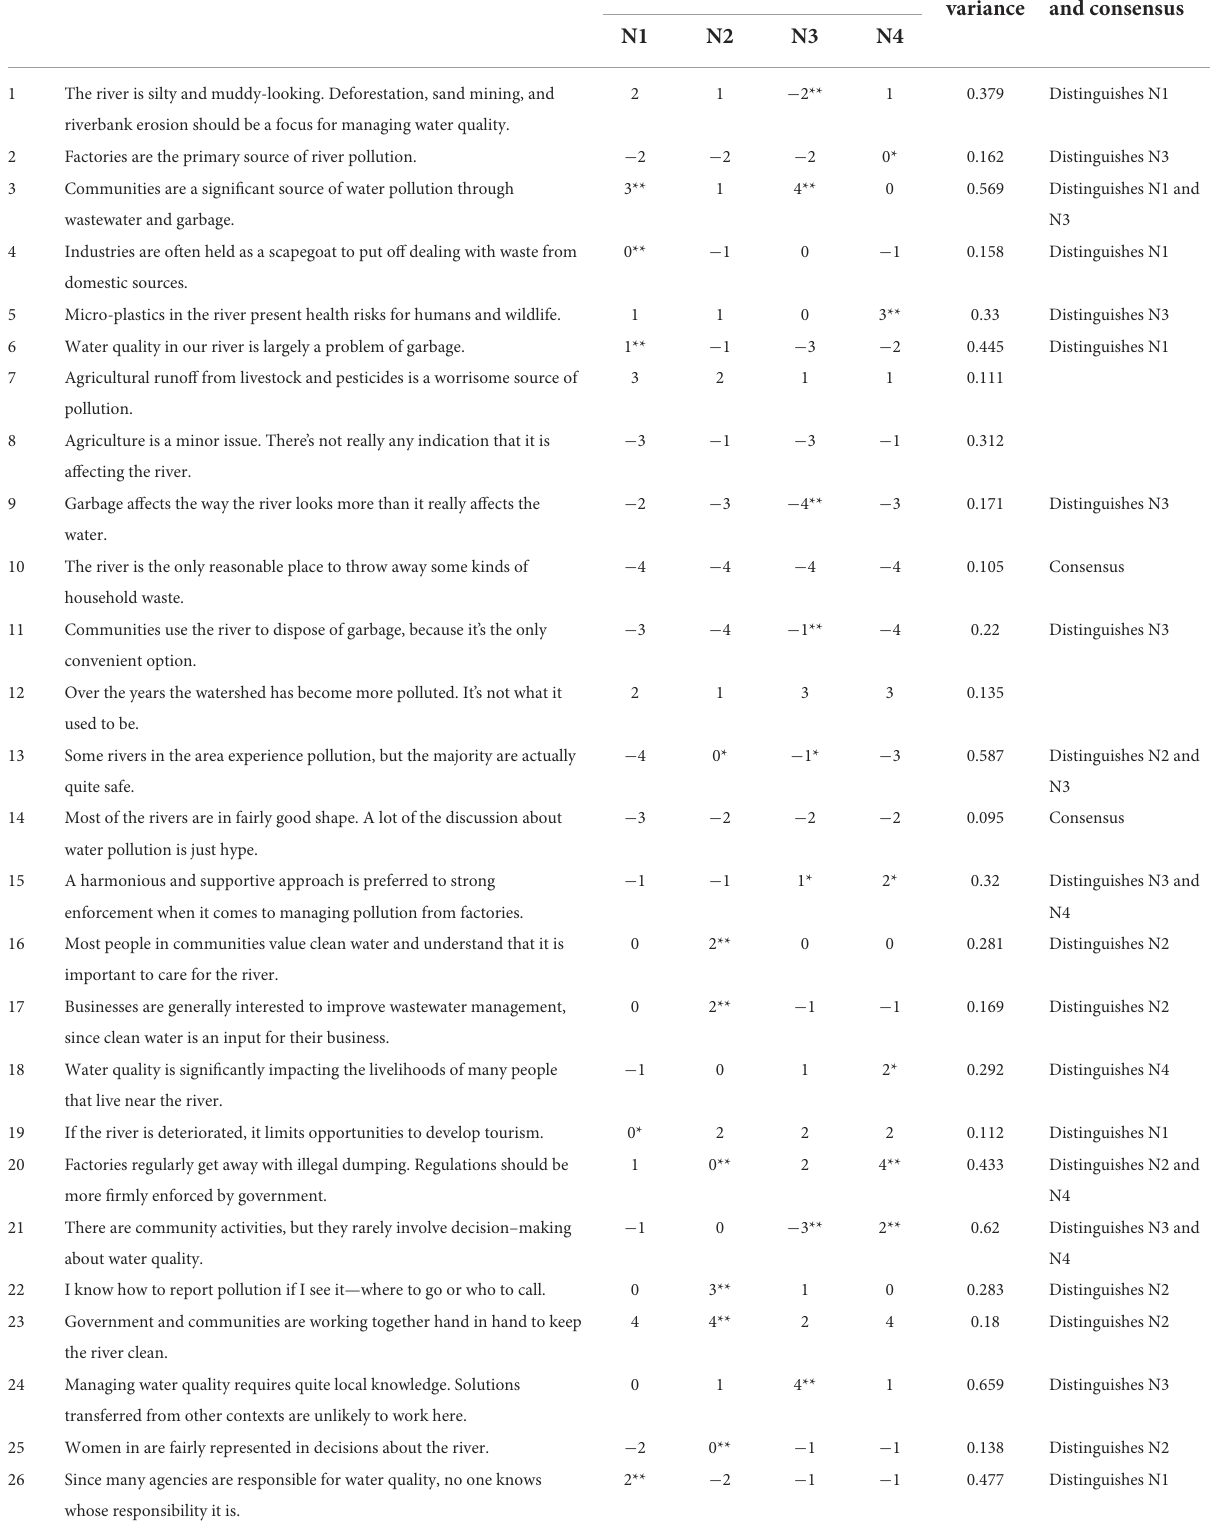
TABLE 7 Q-sort statement rankings for idealized Conditions factor